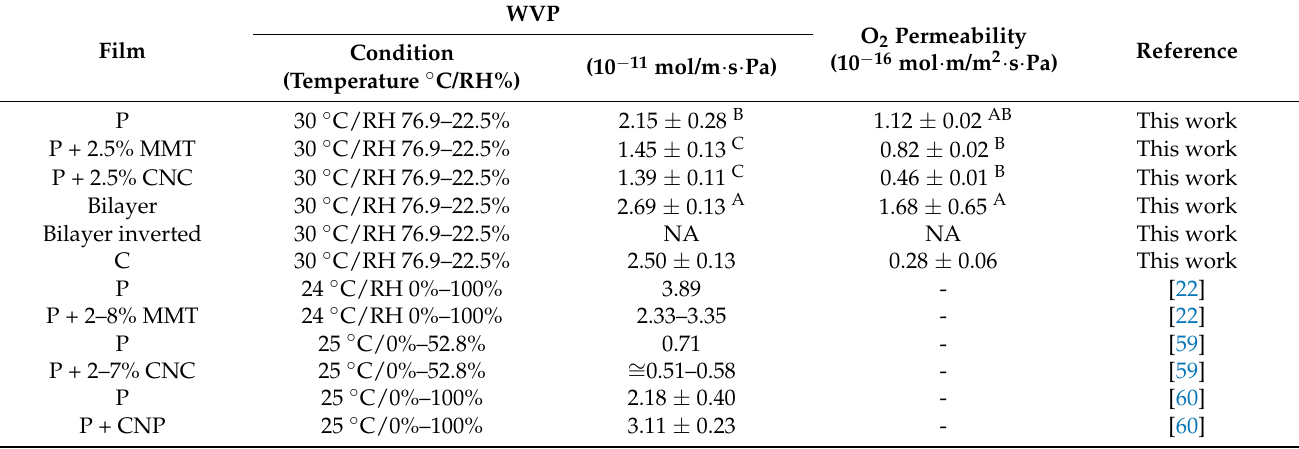
Table 3. Water vapor and oxygen permeability of the films and comparison with WVP data from